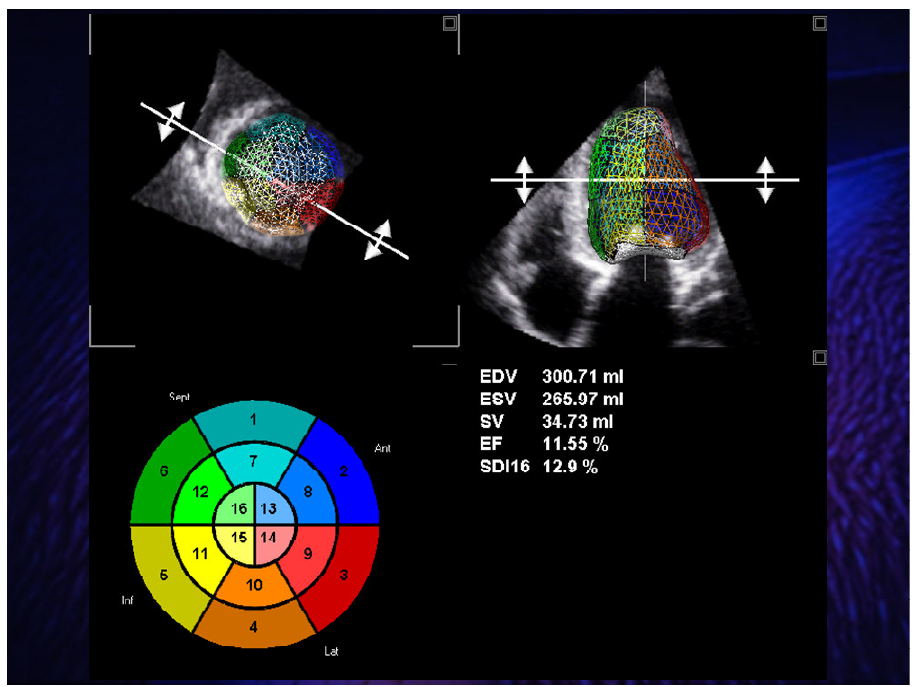
FIGURE 5. Young adult with severe form of DCM, his EF = 11.9% only, measured by three- and four- dimensional LV volume data set. Note the evidence of significant LV intraventricular mechanical dyssynchrony; SDI (systolic dyssynchrony index) = 12.9%.